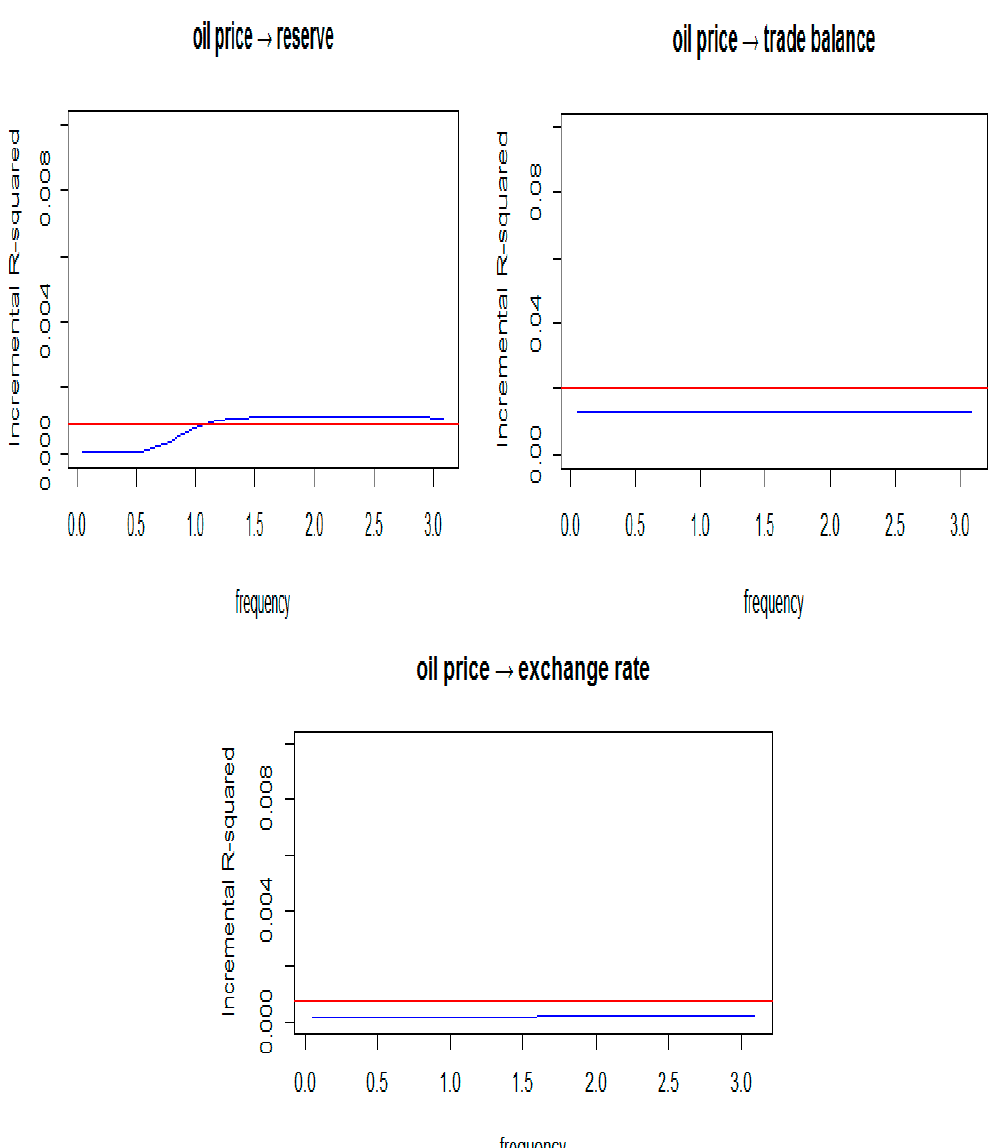
Figure 1. Granger causality of oil price effects on reserve, trade balance, and exchange rate in Nigeria.